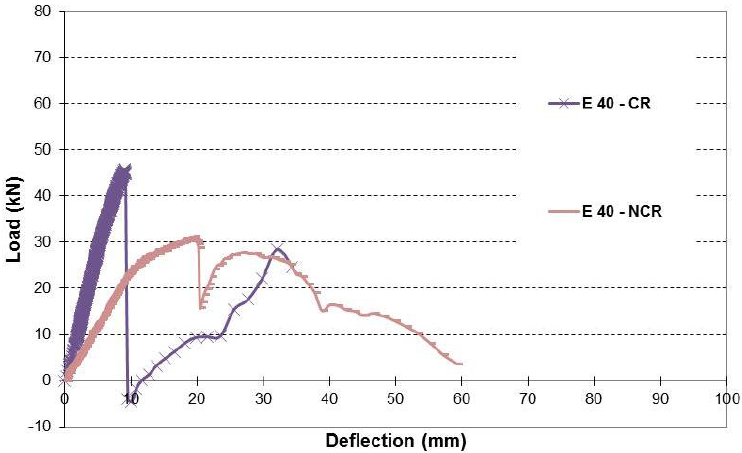
Figure 25. Load-deflection relationship of repaired beams with 32% corrosion level with and without cover.